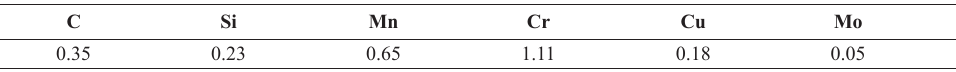
Table 1. Chemical composition of the steel investigated (% wt.)